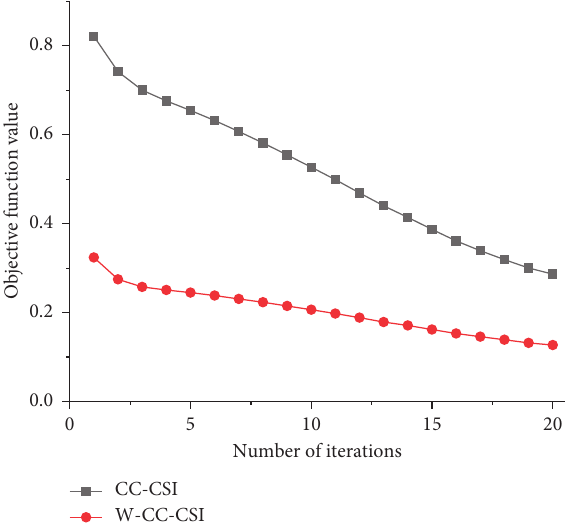
Figure 22: The comparison of convergence curves between CC-CSI and